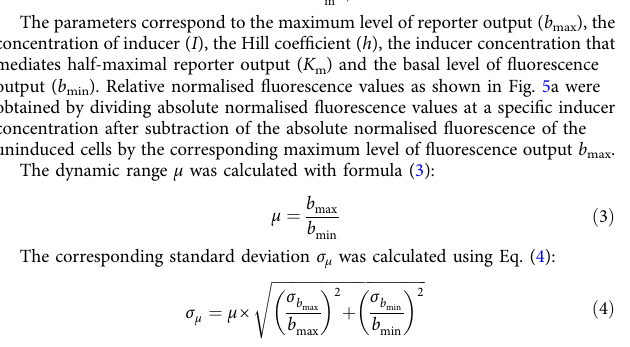
Table 11. Data analysis was performed using Chromeleon 7 (Thermo Scienti fi c). Metabolite concentrations were quanti fi ed using calibration curves generated from running standards of known concentrations which were prepared the same as the